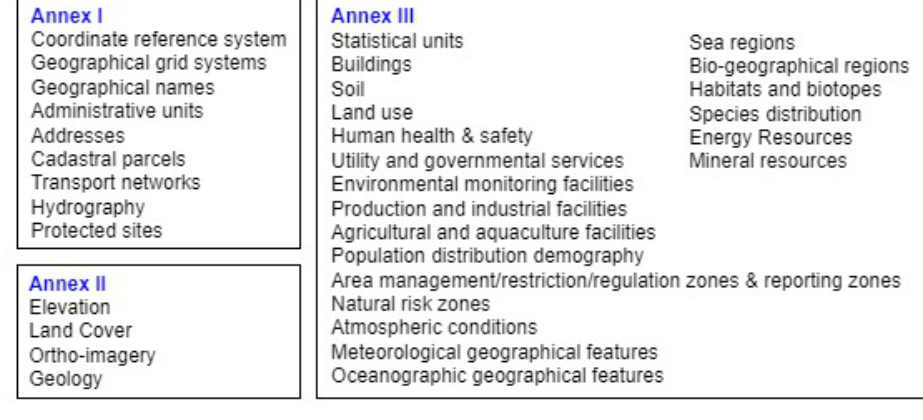
Figure 1. INSPIRE data themes, organized in three annexes. Source: INSPIRE directive